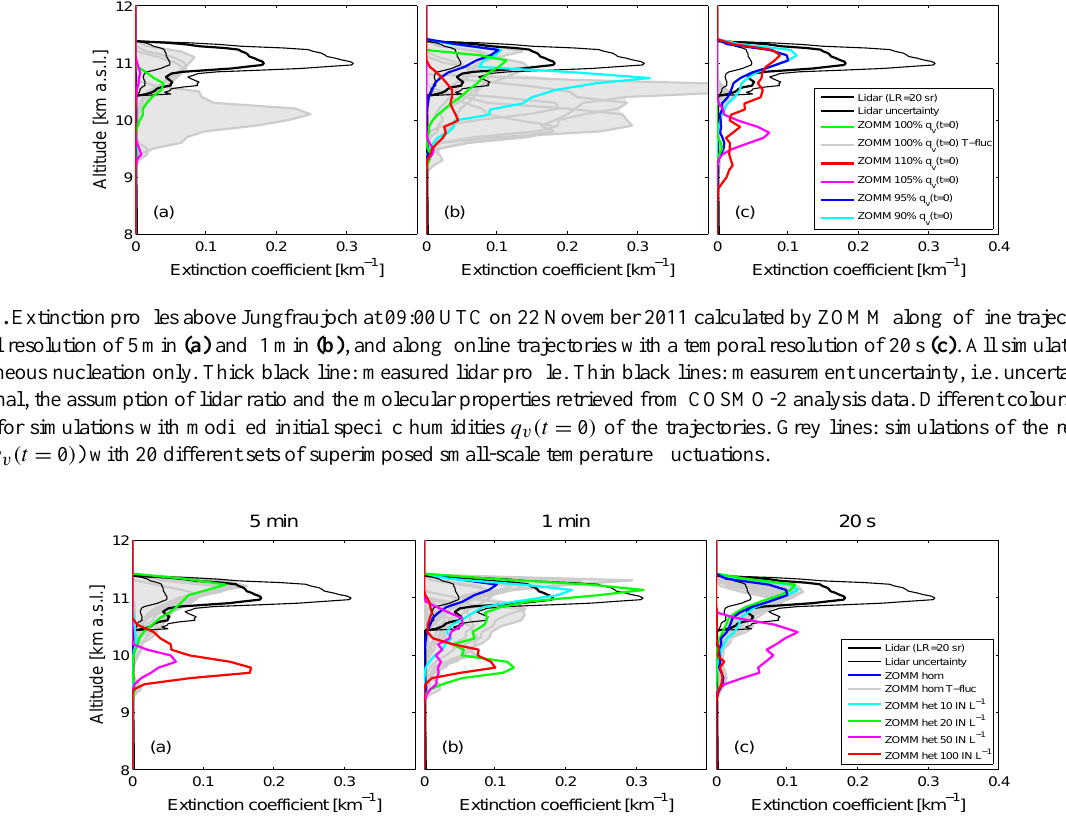
Figure 9. Extinction profiles as in Fig. 8 but assuming different ice nuclei number densities and an initial humidity q v (t = 0 ) of 5% lower than the value derived from the COSMO-2 model. Reference run (without heterogeneous ice nucleation): identical to the simulation shown by the cyan line in Fig. 8. Grey curves: simulations of homogeneous run with superimposed small-scale temperature